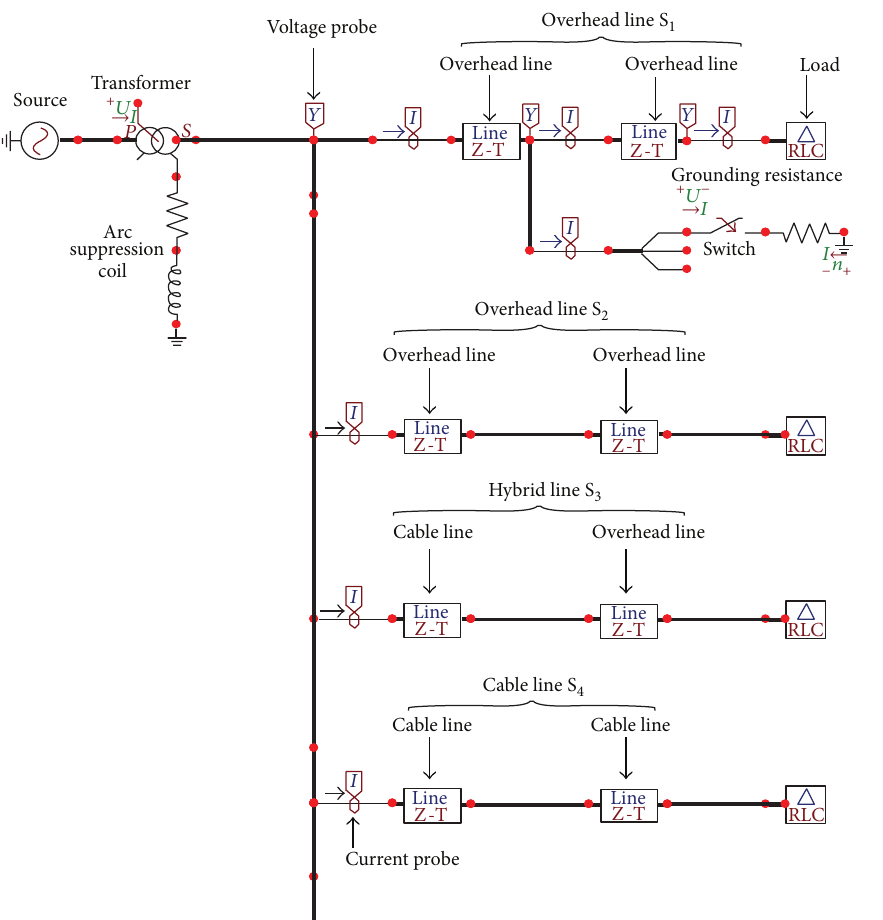
Figure 5: Arc suppression coil grounding system. Table 2: 𝑓 𝑇 of each line with S